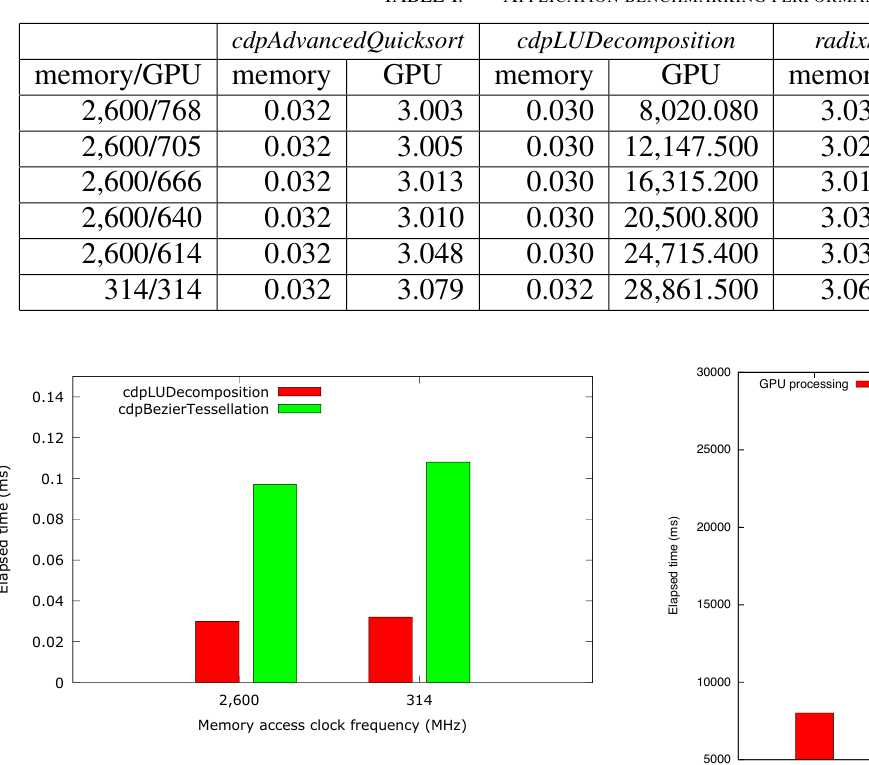
Figure 12. Memory access elapsed time.